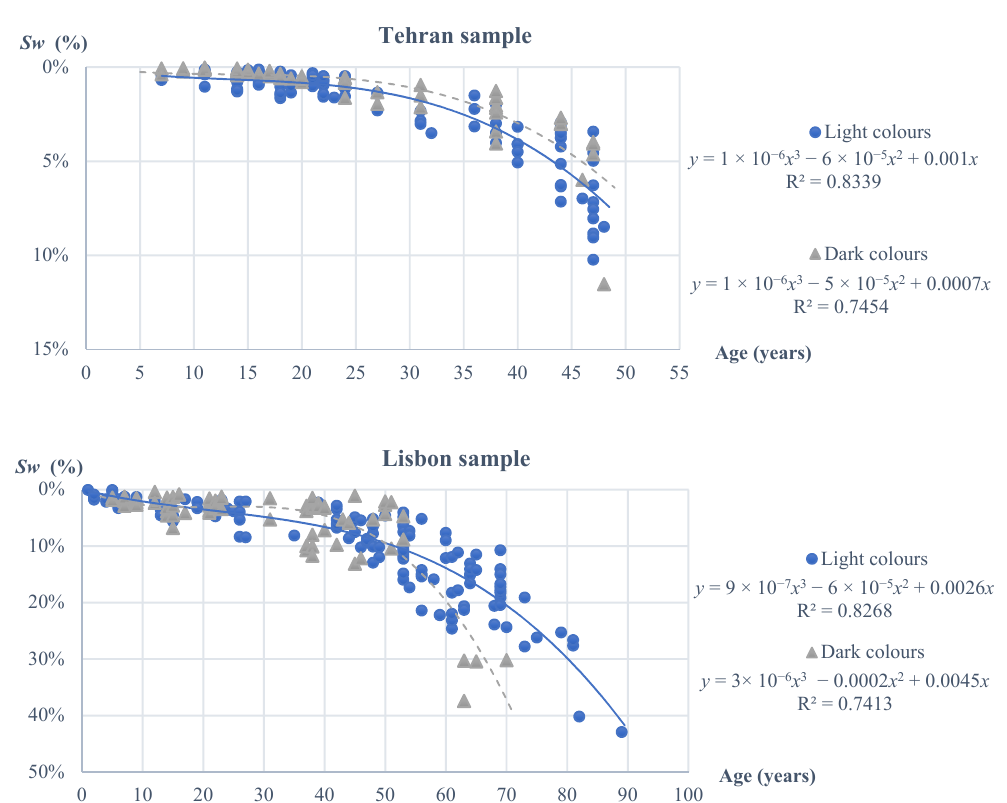
Figure 10. Degradation curves of the Tehran and Lisbon samples, according to the colour of stone.